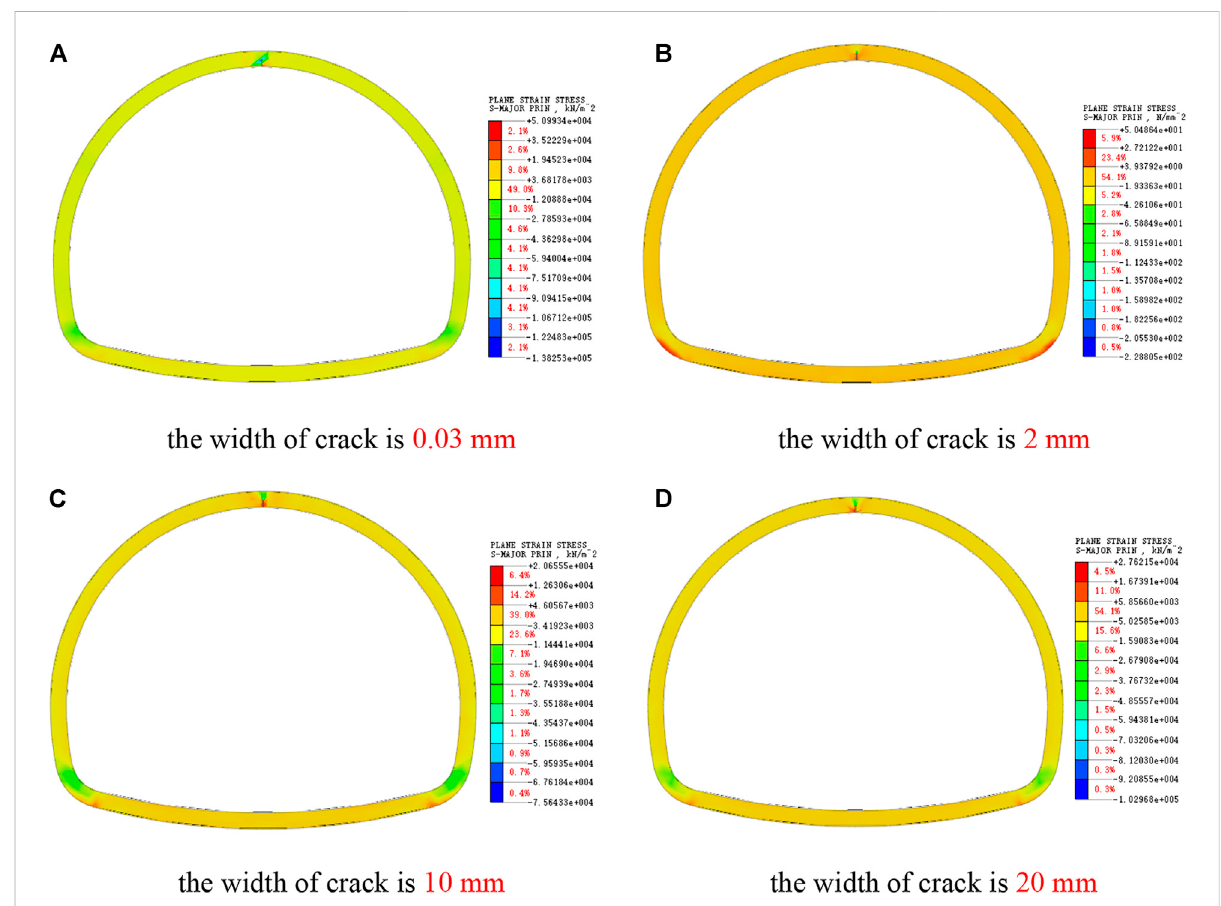
FIGURE 5 Cloud map of major principal stress of vault crack. (A) The width of crack is 0.03 mm. (B) The width of crack is 2 mm. (C) The width of crack is 10 mm. (D) The width of crack is 20 mm.